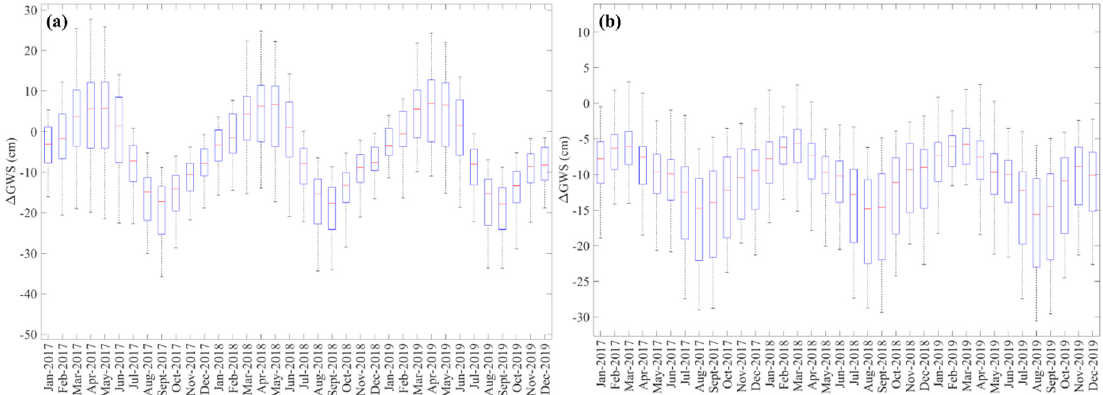
Figure 9. Box plot of the forecasted monthly groundwater anomalies of ( a ) Upper Colorado River basin and ( b ) Lower Colorado River basin.